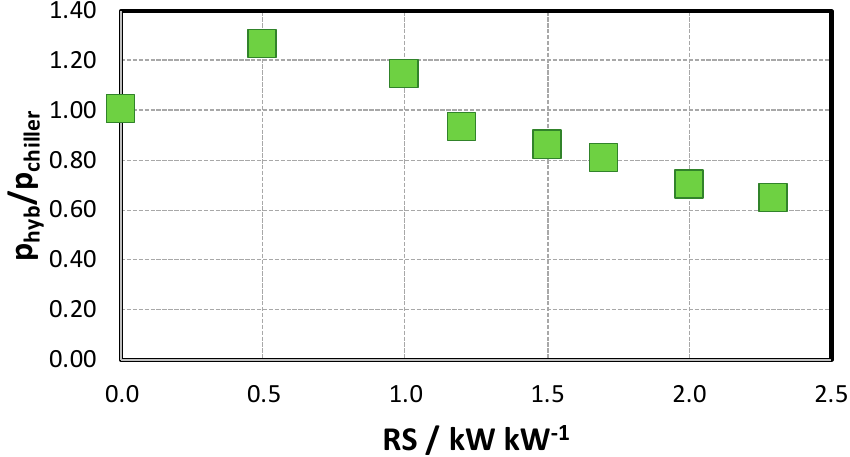
Figure 14. Sensitivity analysis - results for the relative size of thermal/electric units.